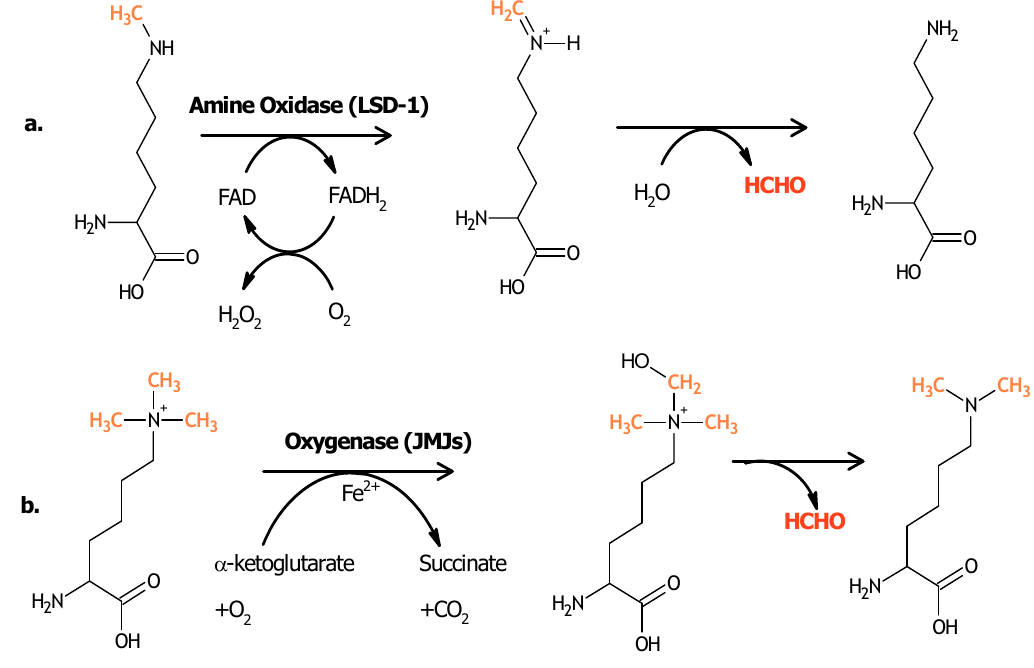
Figure 4. Mechanisms of histone demethylation [40]. ( a ) The proteins having an amine-oxidase FAD-dependent activity require at least one atom of hydrogen on the lysine’s amine group, implying these proteins’ activity on the mono- and dimethylated